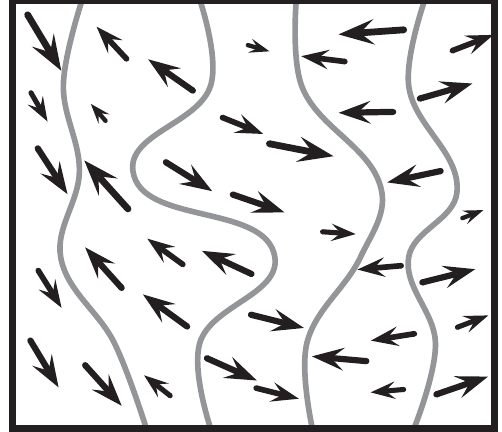
FIG. 2. Goldstone mode in the SDW glass. The configuration of the domain walls is identical to the ground state, but the orientation of the moments slowly varies in